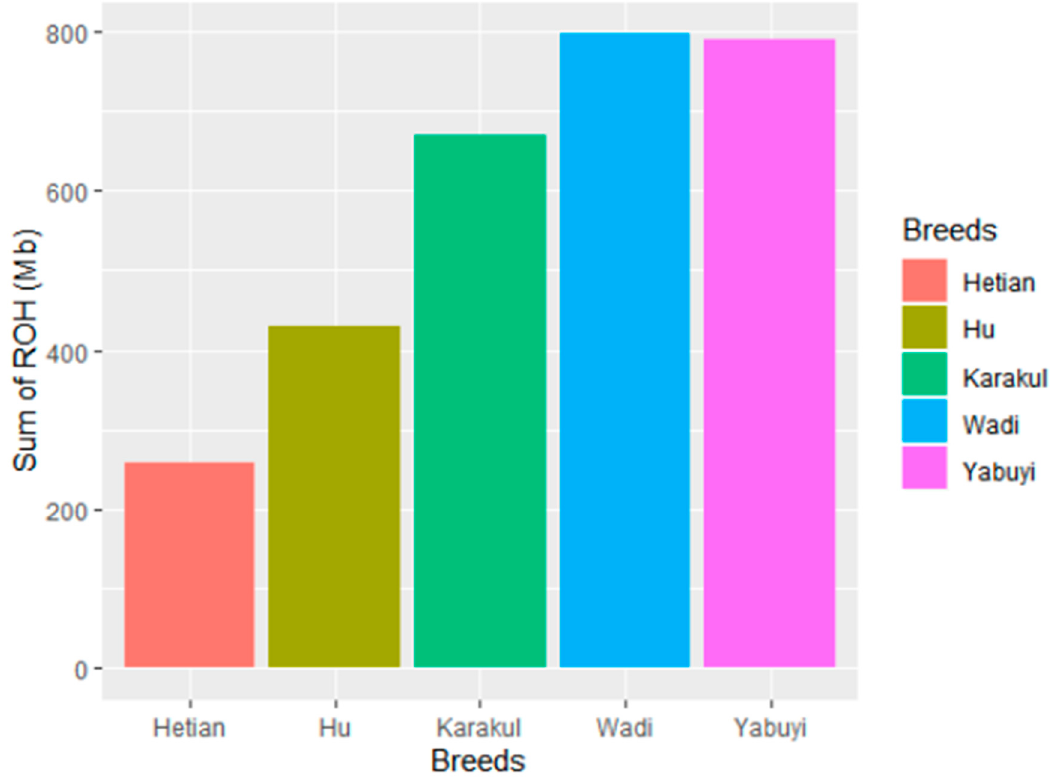
Figure 3. Runs of homozygosity patterns length of the genome across five Chinese sheep breeds.